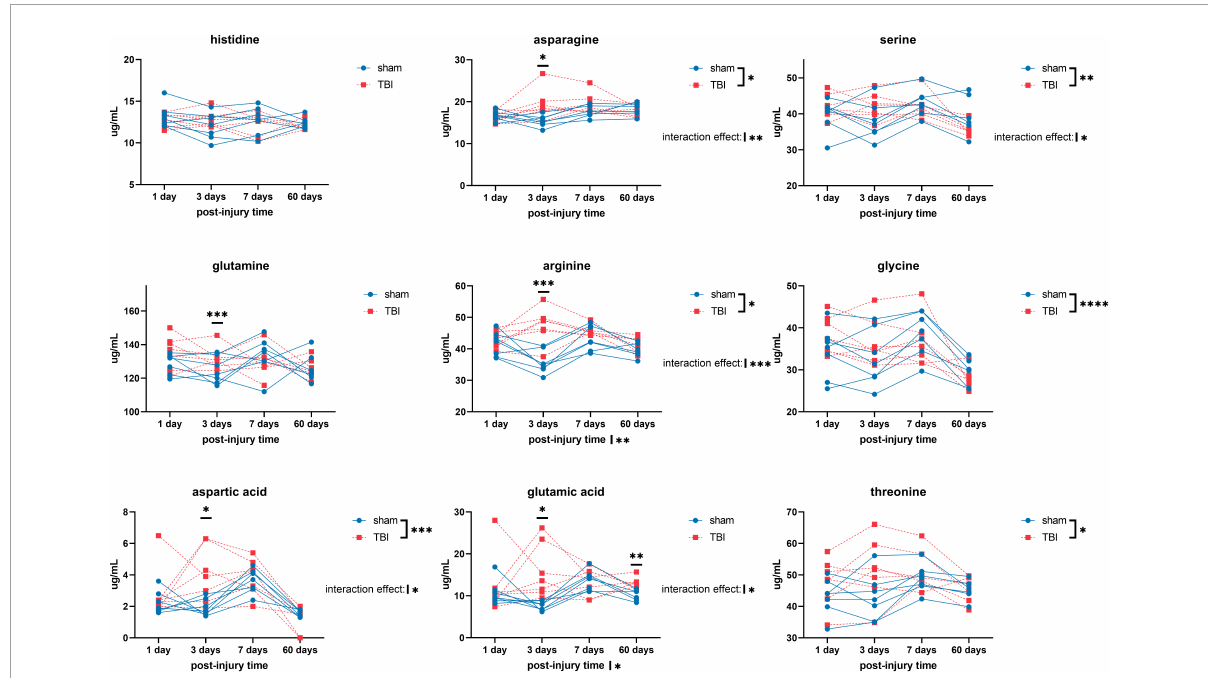
FIGURE1 Plasma levels of amino acids: histidine, asparagine, serine, glutamine, arginine, glycine, aspartic acid, glutamic acid, and threonine of sham and traumatic brain injured (TBI) animals at day one, three, seven, and sixty post-procedure. Asterisks ( ∗ ) next to sham/TBI legends, post-injury time axis label, and interaction effect indicated statistically significant group, post-injury time, and group × post-injury time effects, respectively, in a two-way repeated measures analysis of variance (ANOVA). ∗ On the graph at each timepoint indicated significant difference between TBI and sham animals at each timepoint, Fisher’s Least Squared Difference post-hoc test. ∗ P -value < 0.05, ∗∗ P -value < 0.01, ∗∗∗ P -value < 0.001, ∗∗∗∗ P -value <